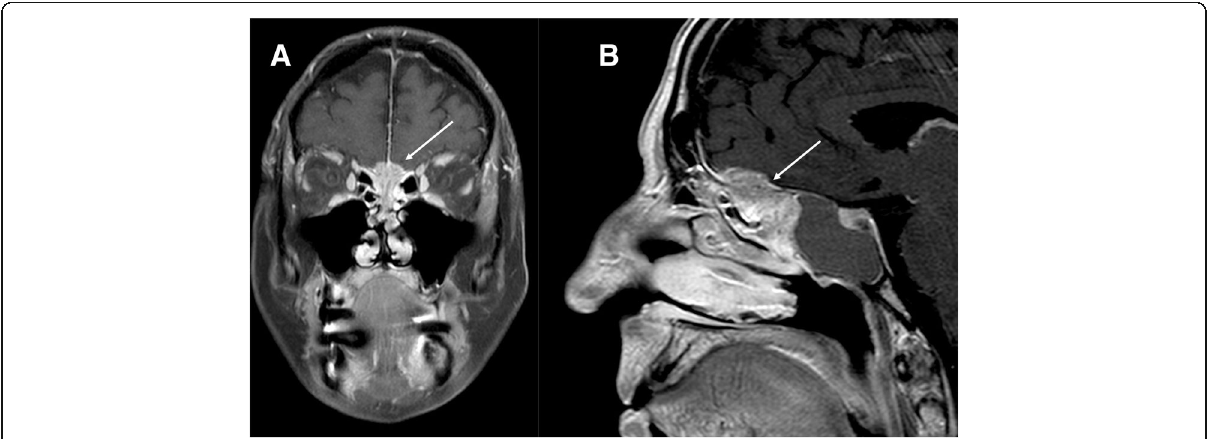
Fig. 17 Esthesioneuroblastoma. MRI T1-weighted fat-suppressed post-gadolinium sequence, coronal ( a ) and sagittal ( b ) images show a marked enhanced large median mass (arrows) in the sinonasal region growing superiorly into the inferior frontal region of the